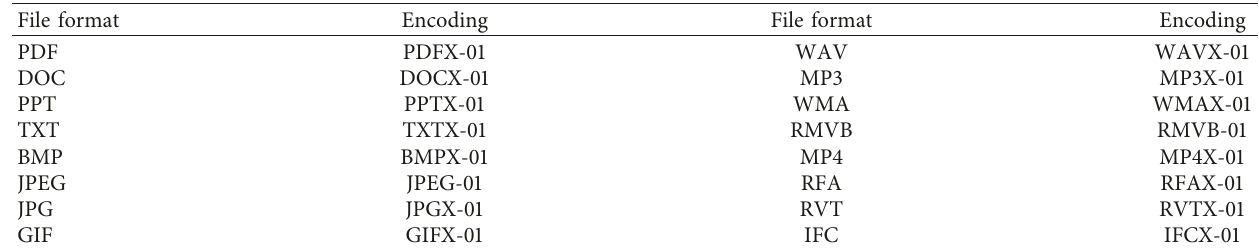
Table 11: Encoding of